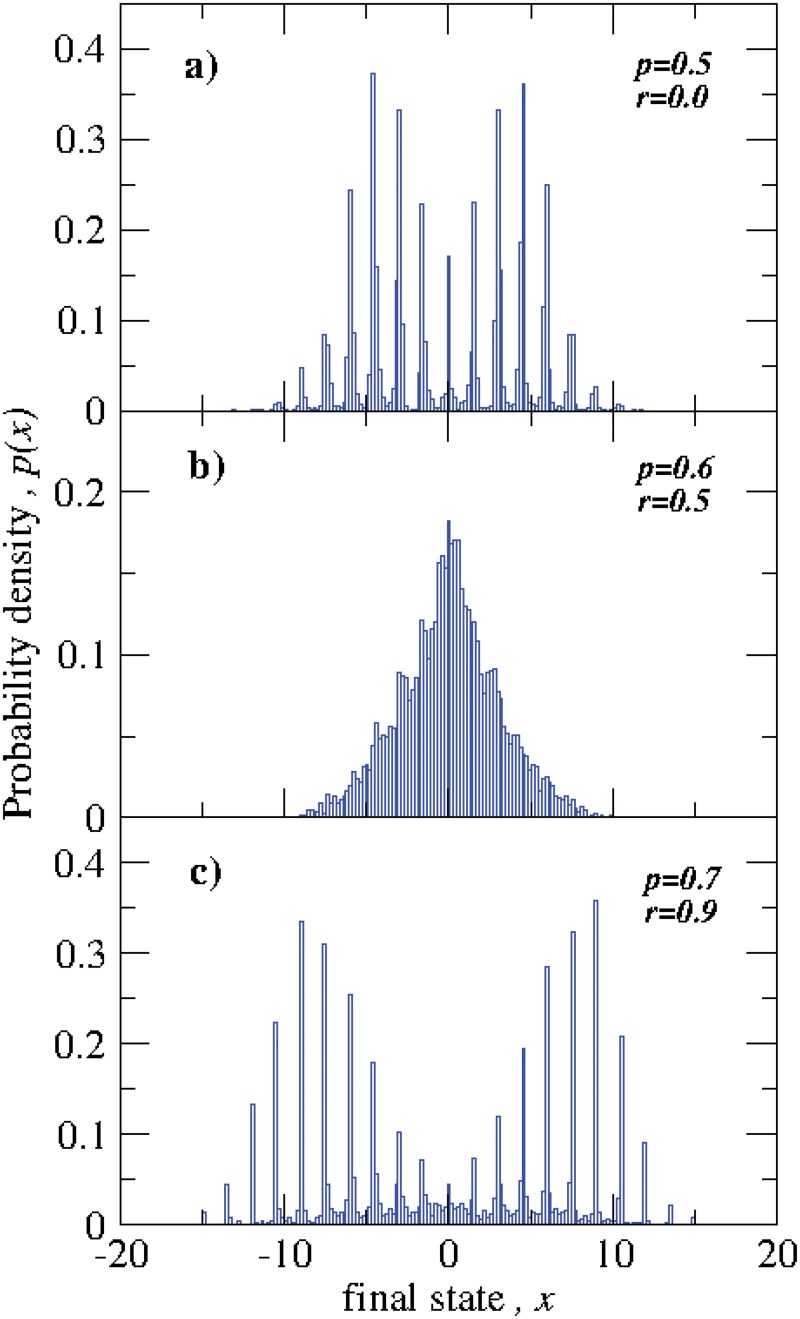
Probability distributions of final states for different values of p and r.We have constructed the probability density by using the results of 10 independent realizations. For small (r = 0.0) and large values (r = 0.9) (i.e., when number competitors or cooperators dominates the system, respectively) and intermediate values of p, the probability functions of final states exhibit multiple narrowly peaked local distributions, while for the case of equal number of cooperators and competitors, p(x) is narrow.